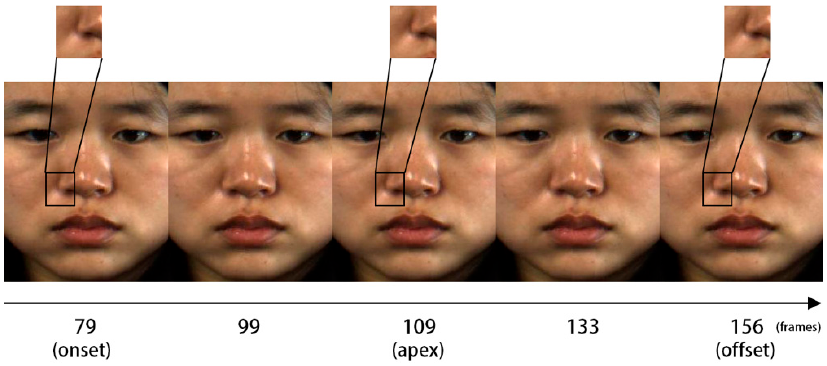
Figure 1. One necessary morphological patch (NMP) of disgust, micro-expression sequence.